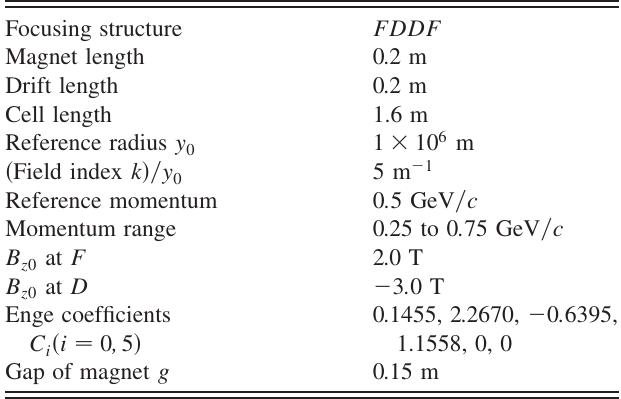
TABLE I. Parameters of a FDDF